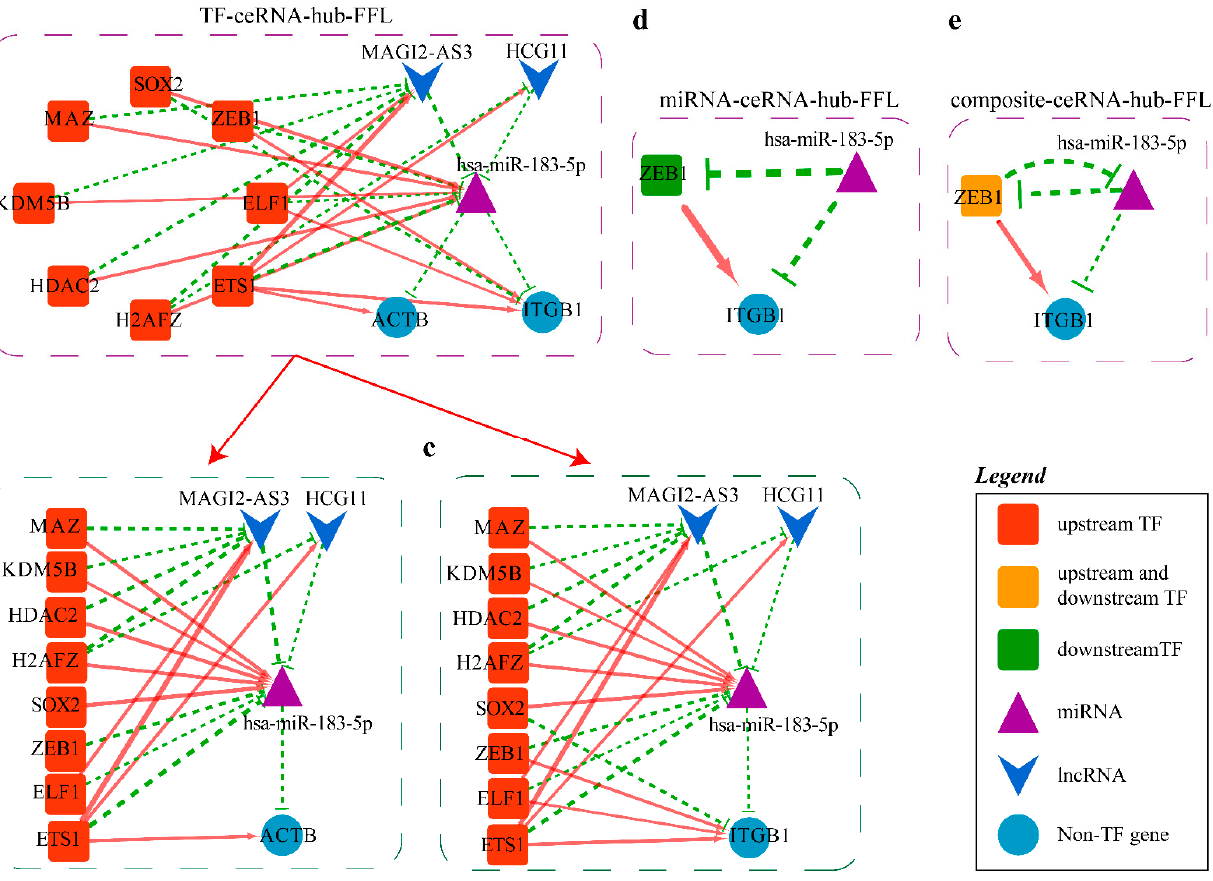
Figure 14. MiR-183-5p related ceRNA-hub-FFL subnetworks: ( a ) MiR-183-5p related I-FFL network; ( b , c ) Subplots of individual genes regulated by miR-183-5p in I-FFL; ( d ) MiR-183-5 related II-FFL network; ( e ) MiR-183-5p related III-FFL network. Green dashed line indicates inhibition, red indicates activation, and line thickness indicates the strength of correlation.